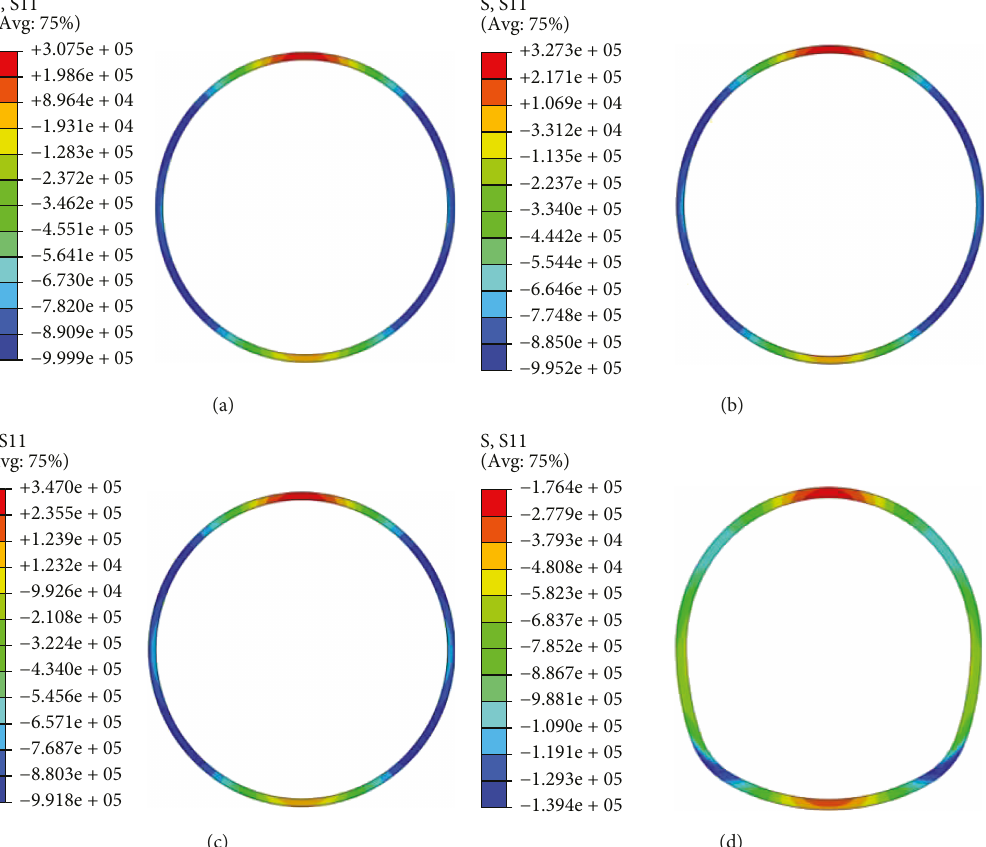
Figure 25: The maximum principal stress of the lining of four conditions (unit: Pa). (a) Condition 1; (b) condition 4; (c) condition 5; and (d) condition